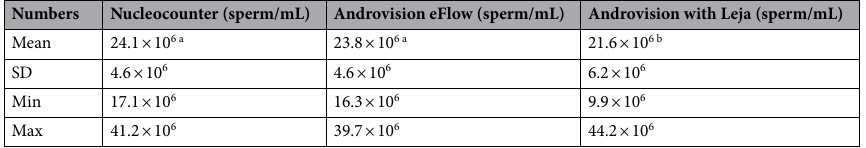
Table 2. Semen concentration measurement results (mean, SD, minimum and maximum) from 109 diluted boar sperm samples. Mean values differ significantly depending on measurement method ( a,b P <